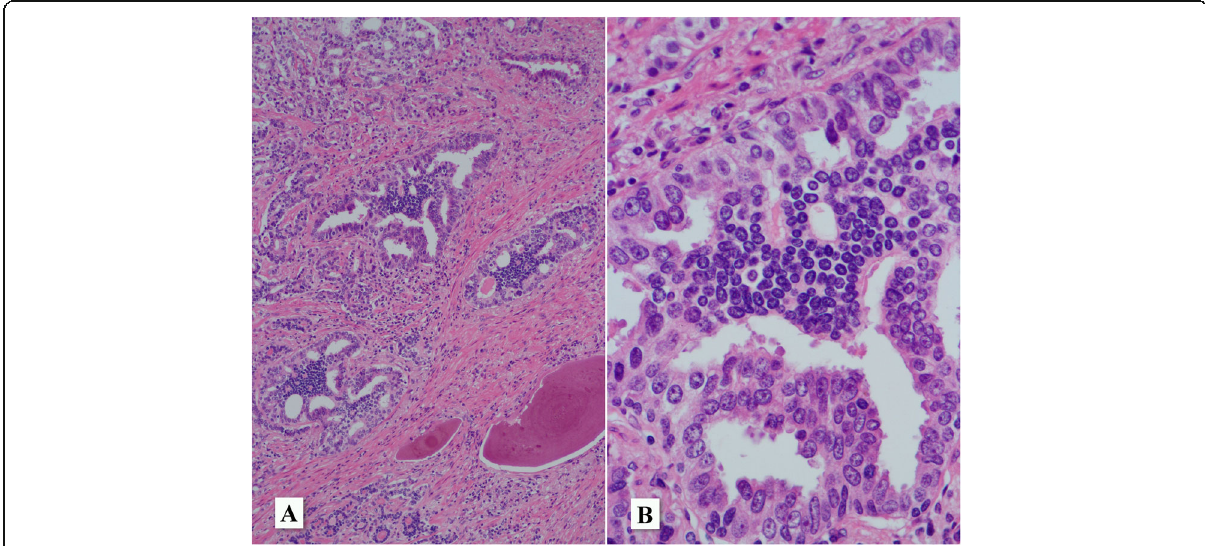
Fig. 1 Small cell-like change in intraductal carcinoma of the prostate. Aggregates of small cells in the center of dense cribriform lesions. Hematoxylin and eosin stain: A (100x) and B (400x)